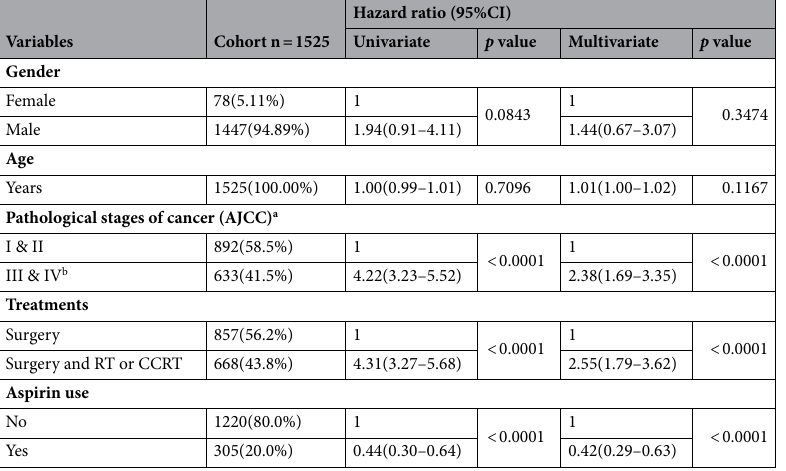
Table 2. Univariate and multivariate Cox proportional hazards of prognostic factors for OSCC survival, Model A: adjusted for pathological stages of cancer (AJCC) and other covariates as shown in the table. 95% CI 95% Confidence interval, RT Radiotherapy, CCRT Concurrent chemoradiotherapy. a Pathological AJCC Cancer Staging 7th Edition. b Stages IVa and IVb only.